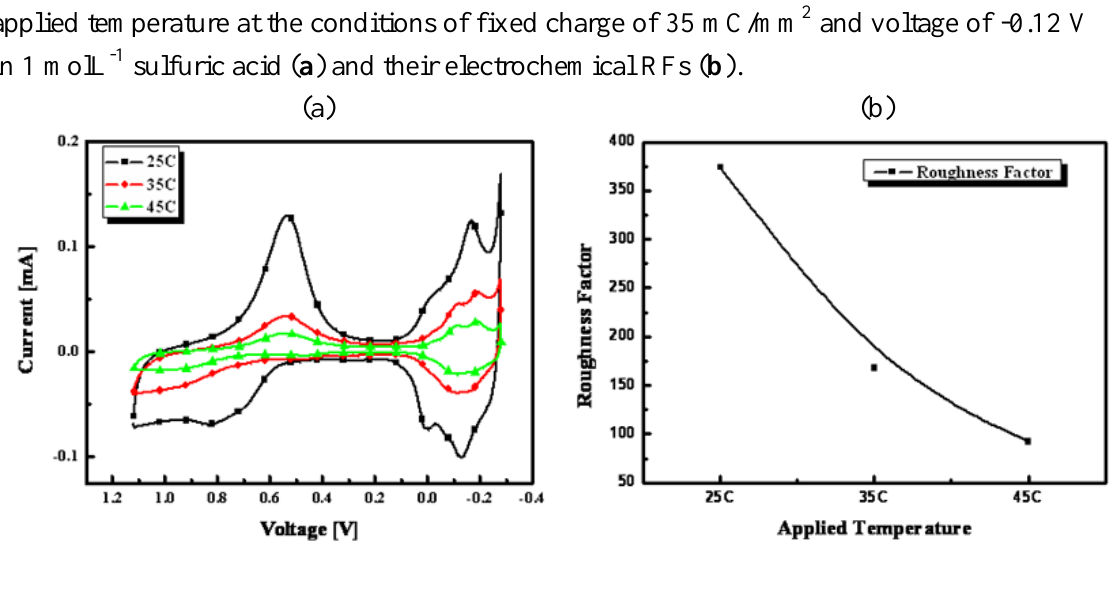
Figure 6. Cyclic voltammograms of nanoporous Pt electroplated between 25 and 45 ° C of applied temperature at the conditions of fixed charge of 35 mC/mm 2 and voltage of -0.12 V in 1 molL -1 sulfuric acid ( a ) and their electrochemical RFs ( b ).